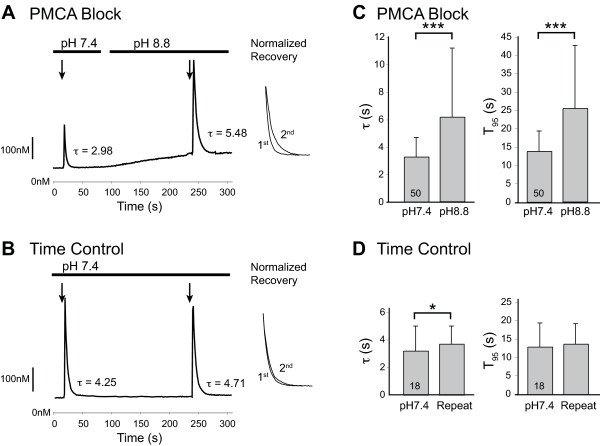
PMCA regulates [Ca2+]c in sensory neurons at rest and after activation. Sample traces demonstrate that blocking PMCA by switching from bath solution with pH 7.4 to pH 8.8 increases resting [Ca2+]c levels (A), whereas time alone has no effect (B). Transients induced by application of high K+ solution (50 mM for 0.3 s, arrows) are prolonged by pH 8.8, as measured by recovery rate constant (τ) and by the time to achieve 95% recovery to baseline (T95), as shown in the sample traces (A) and summary data (C). Time alone minimally prolongs τ but not T95 (B, D). Insets in panels A and B show superimposed recovery traces from the first and second depolarizations after normalization to identical amplitudes. Bar graphs show mean ± SD; numbers in bars indicate n; * P < 0.05, *** P < 0.001, by paired T-test.